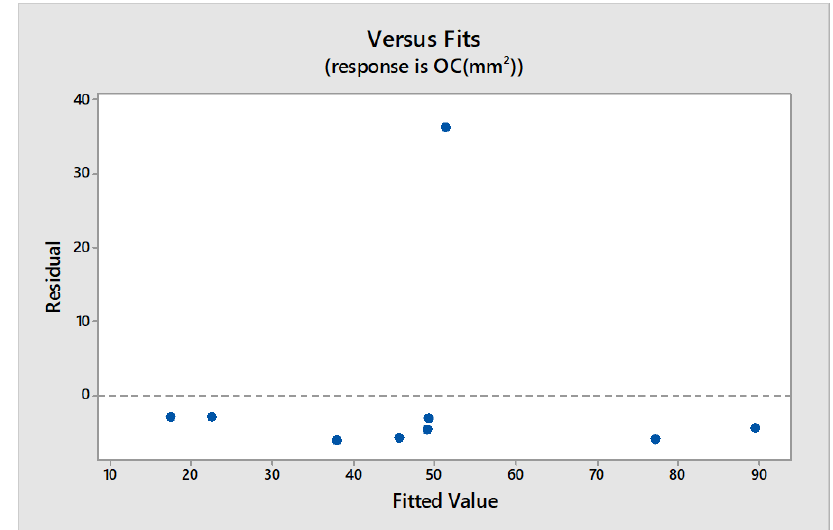
Fig. 7. Residuals versus fits plot for OC